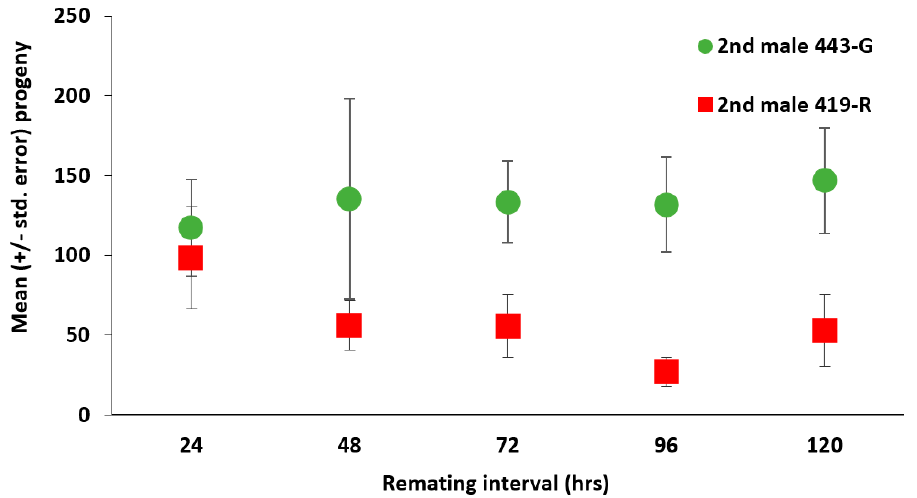
Figure 2. Mean (± std error) progeny produced by A. ludens females mating first with a 443-G male and then mating with a 419-R male (red squares), or females mating first with a 419-R male, and then a 443-G (green circles) according to the female sexual refractory period. Females were offered the second male 24, 48, 72, 96, or 120 h after first mating. There were only significant differences between strains. GLM Binomial distribution χ 2 = 33.074, df = 1, 81, p < 0.001.